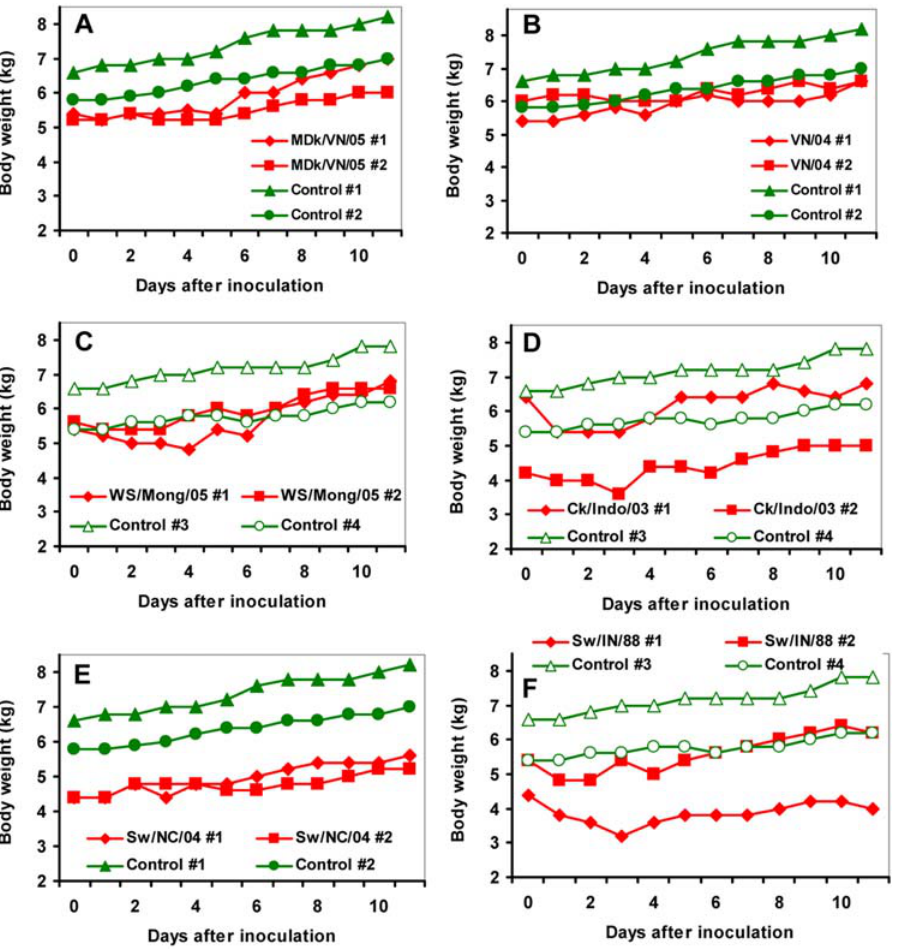
Figure 2. Pig weight changes during influenza virus infection. Shown are results for the two infected pigs for each virus treatment group (pigs # 1 and # 2); compared to one of two independent control groups (control pigs # 1 and # 2, or control pigs # 3 and # 4). H5N1 influenza viruses: MDk/VN/05 ( A ), VN/04 ( B ), WS/Mong/05 ( C ), and Ck/Indo/03 ( D ). Swine H3N2 ( E ) and H1N1 ( F ) influenza viruses.